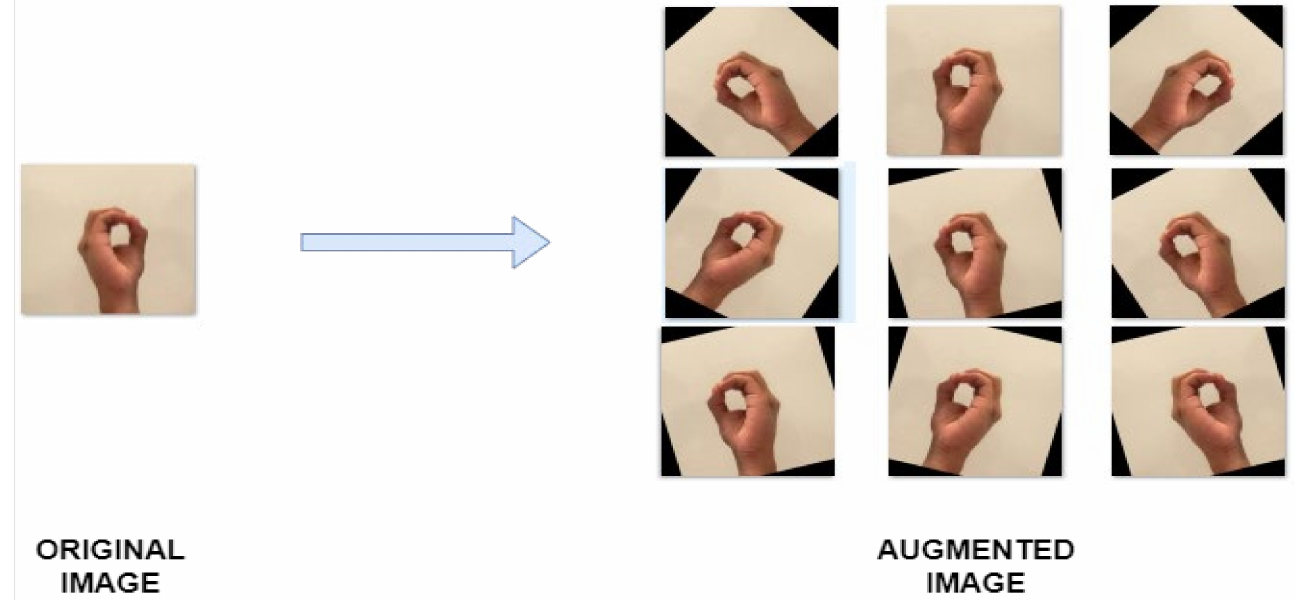
Figure 4. The process of image